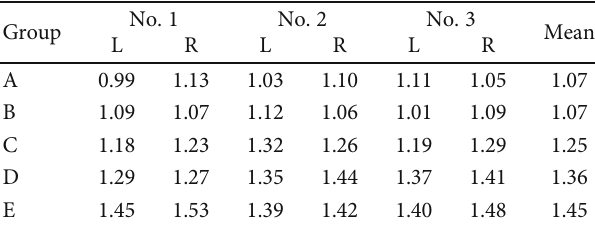
Figure 6: Section morphology of the specimen C2. Table 5: Edge thickness of the reaction layer